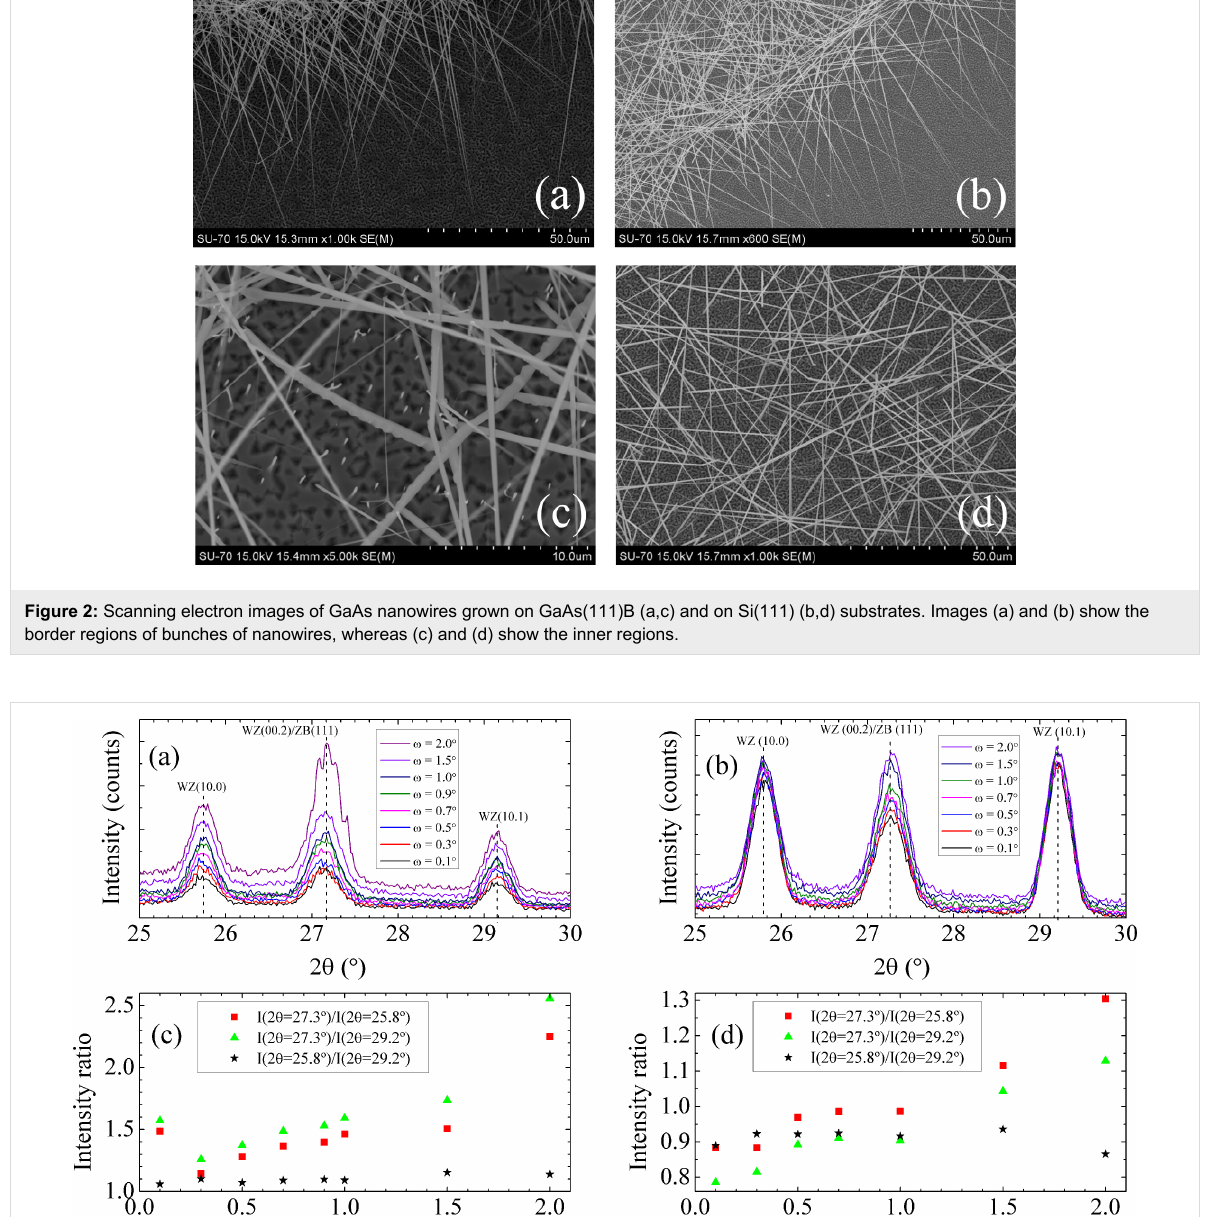
peaks with comparable relative intensities are observed in the range 25–30°. The peaks at ≈ 25.8 and 29.2° are ascribed to reflections in the WZ (10.0) and (10.1) planes,